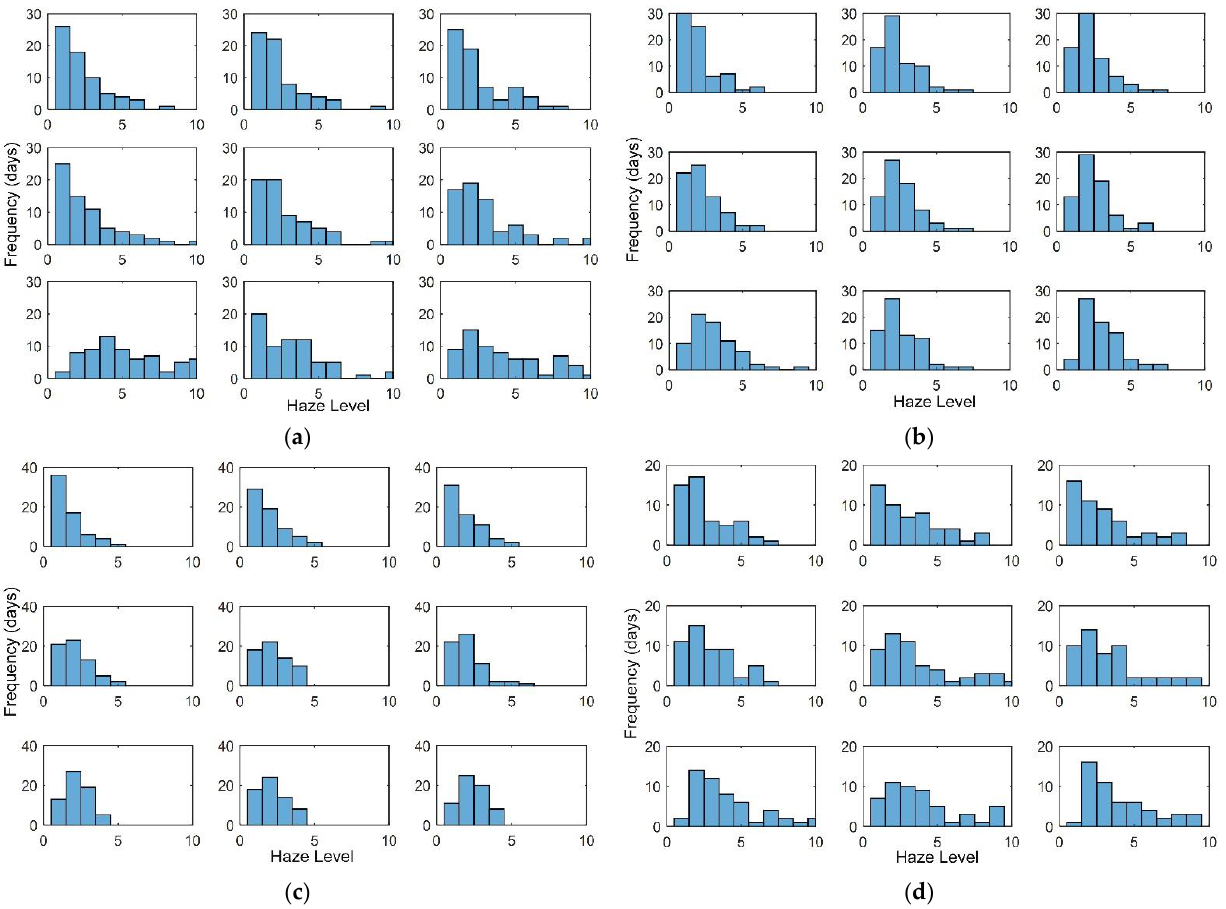
Figure 4. Moran scatter image limit relationship.